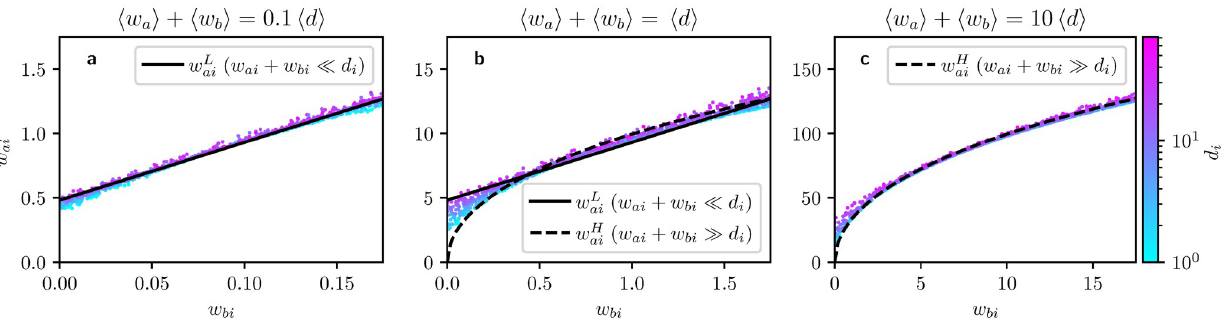
= B ¼ 10 ) and the passive controller targets continuously a b